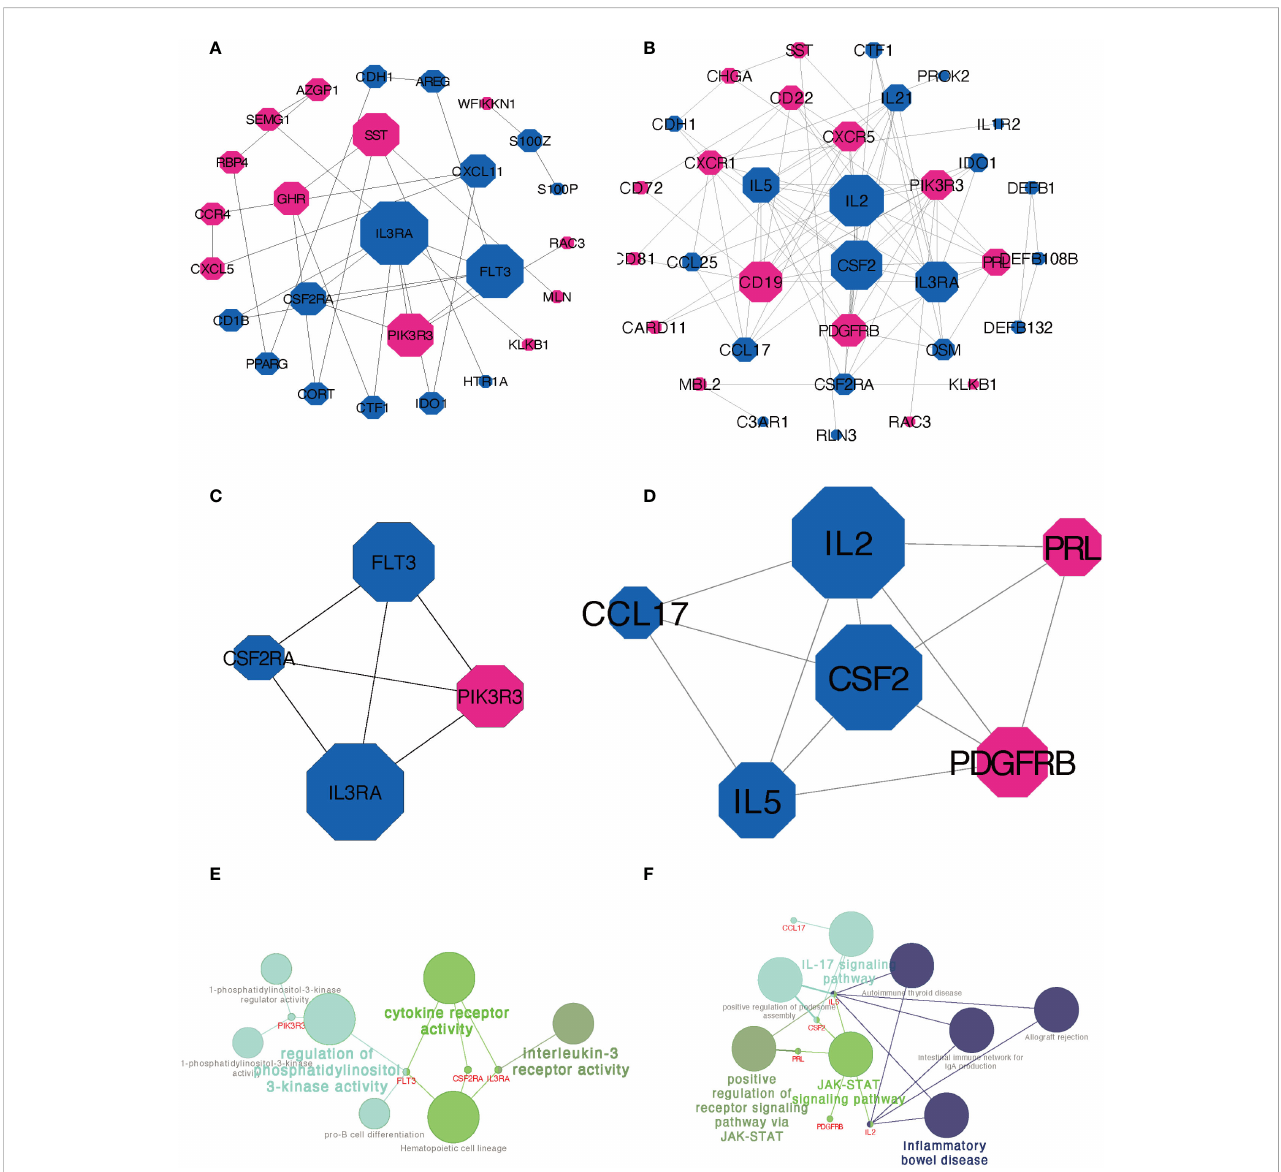
FIGURE 5 PPI network construction and module analysis. (A) PPI network of DEIRGs in Xm TS patients compared with normal individuals. (B) PPI network of DEIRGs in Xp TS patients compared with normal individuals. (C) The most signi fi cant module in Xm TS group. (D) The most signi fi cant module in Xp TS group. Upregulated genes were marked in red and downregulated genes were marked in blue. Node diameter was positively correlated with node connectivity. (E) Functional enrichment analysis of the hub genes in the most signi fi cant module in Xm TS group. (F) Functional enrichment analysis of the hub genes in the most signi fi cant module in Xp TS